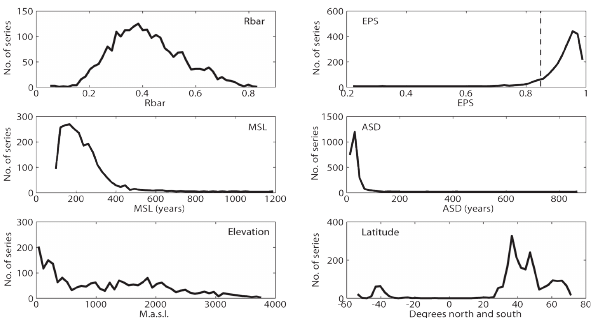
Fig. 2. Binned chronology characteristics for 1901–1970. Rbar is the average inter-series correlation between all series from different trees (Cook et al., 1990); EPS is the expressed population signal and the vertical dashed line denotes the commonly cited 0.85 EPS criterion (Wigley et al., 1984; Cook et al., 1990). Mean 1901–1970 Rbar and EPS values were calculated using a 30yr window that lags 15yr; MSL is the mean segment length; and ASD is the average sample depth (48 bins were distinguished in each variable).